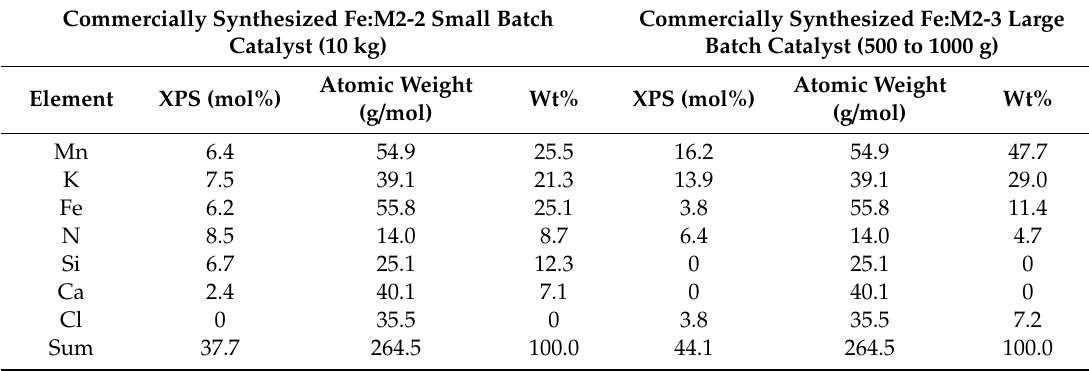
Table 3. Comparing XPS data for two commercially prepared catalyst